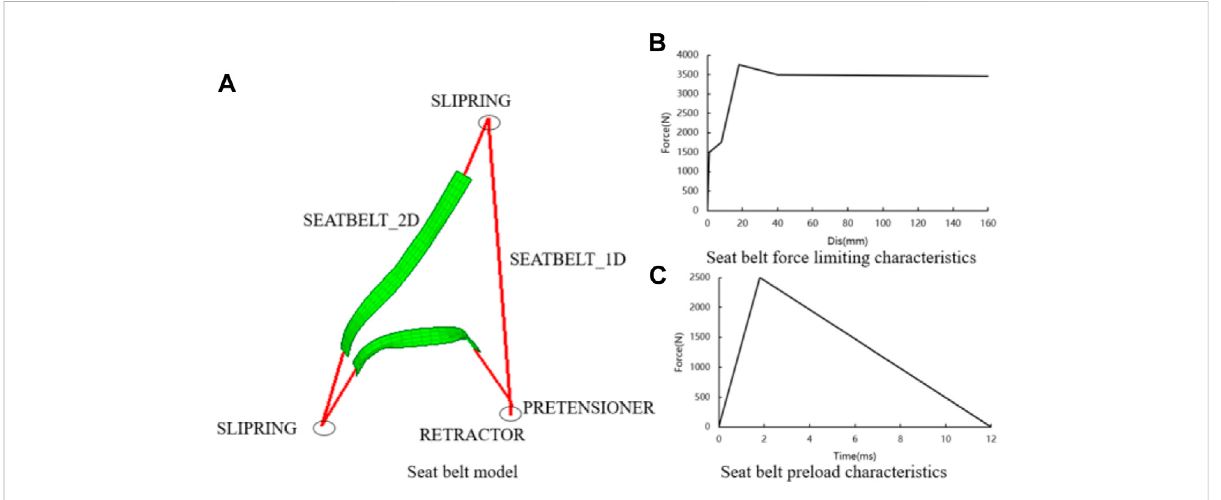
FIGURE 2 Pre-tensioned force-limiting seat belt. (A) composition of pre-tensioned force-limiting seatbelt, (B) force limiting characteristic curve of seatbelt, and (C) pre-tightening curve of